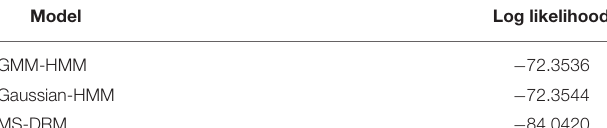
TABLE 4 | Assigning regimes.